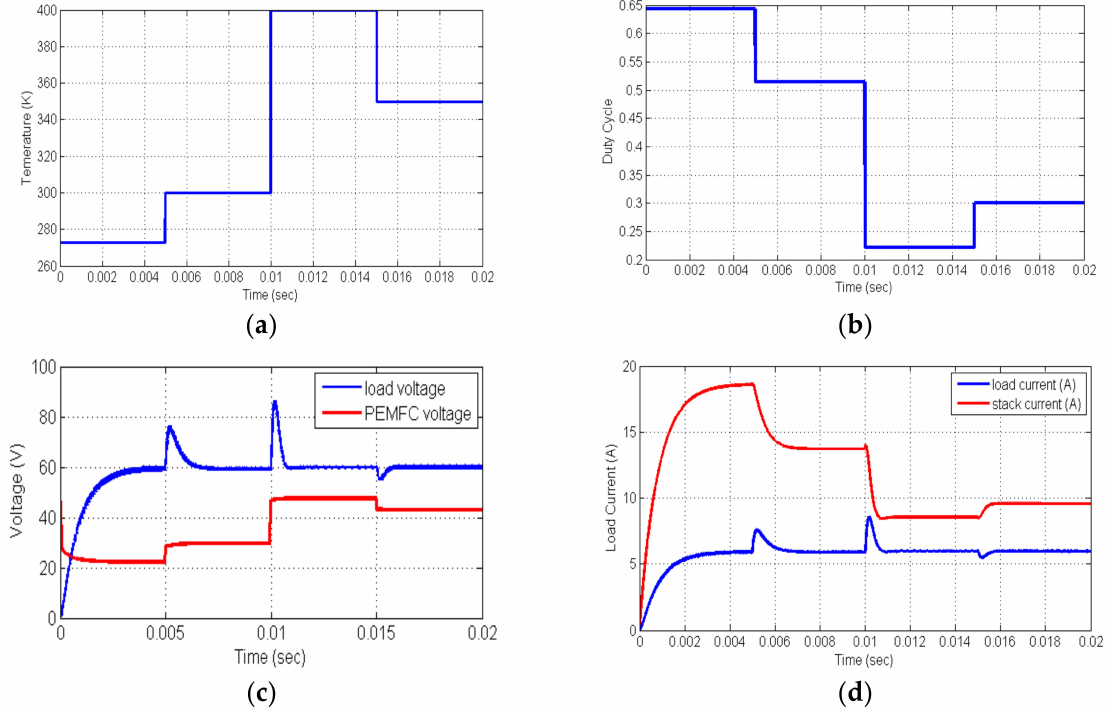
Figure 12. ( a ) Temperature variation, ( b ) Variation of the duty cycle, ( c ) voltage variation, ( d ) current